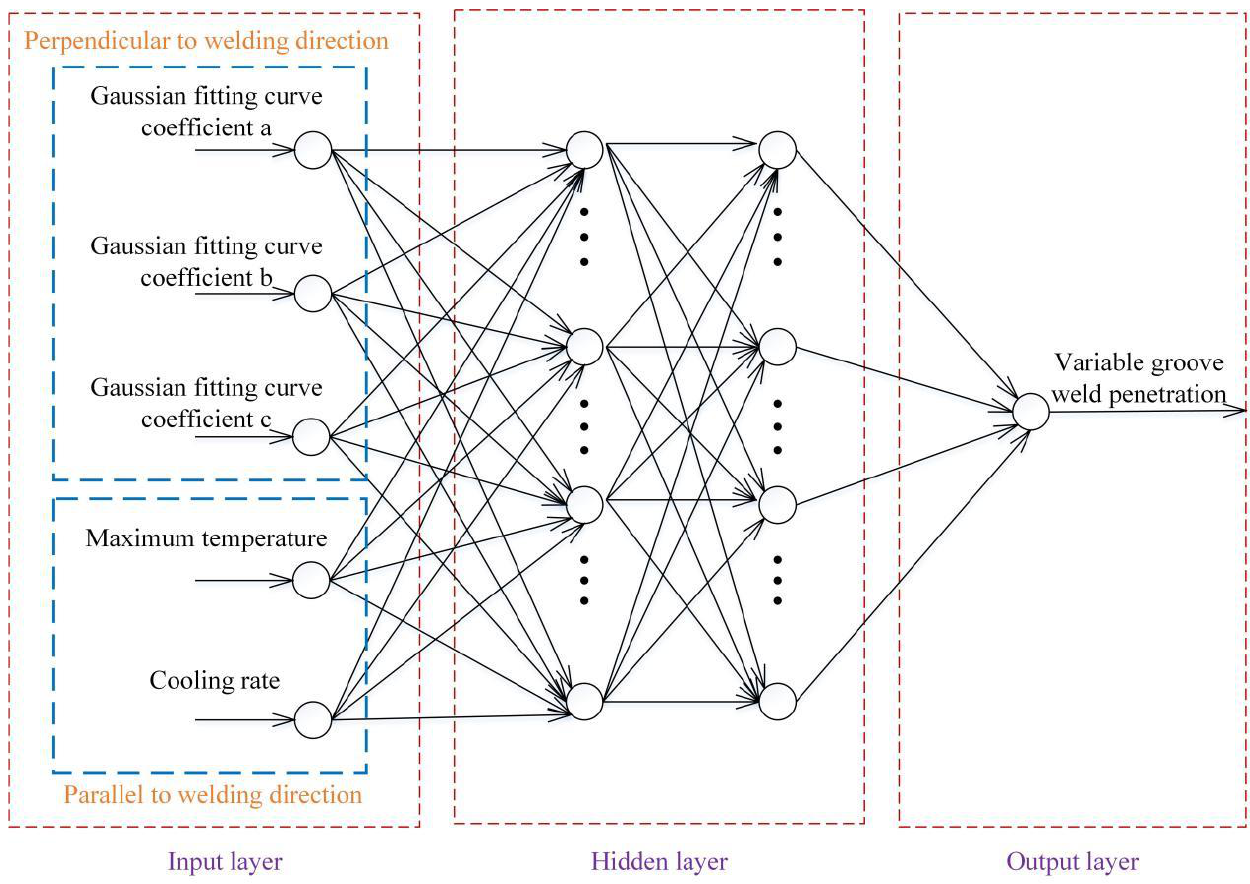
Figure 10. The structure of the penetration state recognition model for a variable groove weld. Prior to training and testing the network model, the data set needed to be normalized.